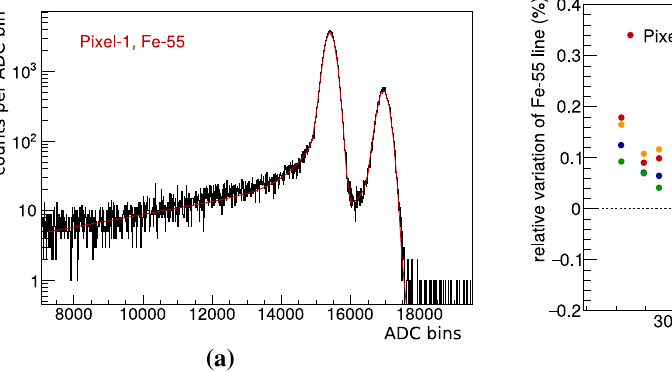
Fig. 3 a EnergydistributioninADCbinsforPixel-1fromacalibration measurement with a Fe-55 source. The red line is the fit of the spectrum. ThetwopeakscorrespondtoX-rayenergiesof5.90and6.49keV. b Rel-